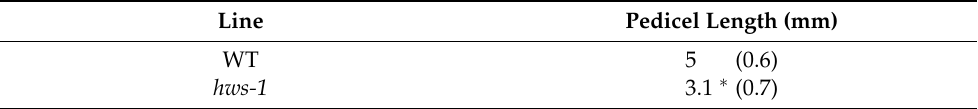
Table A1. Pedicel length is shorter in hws-1 . Pedicel length was measured from the abscission zone to the fruits of 0.8 to 2.5 g (immature green to mature green stages). Values represent means with standard deviations given in brackets ( n = 20). Star ( ∗ ) indicates significant difference at p < 0.001 in an unpaired t